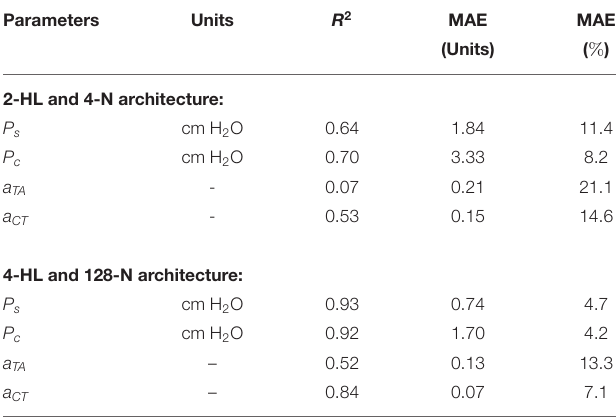
TABLE 4 | Assessment of estimated vocal measures P s , P c , a TA , and a CT using the proposed NN regression method.